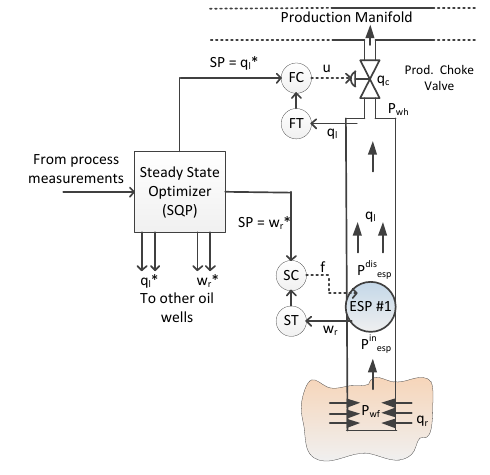
Figure 2: Optimal control structure with two PI con-